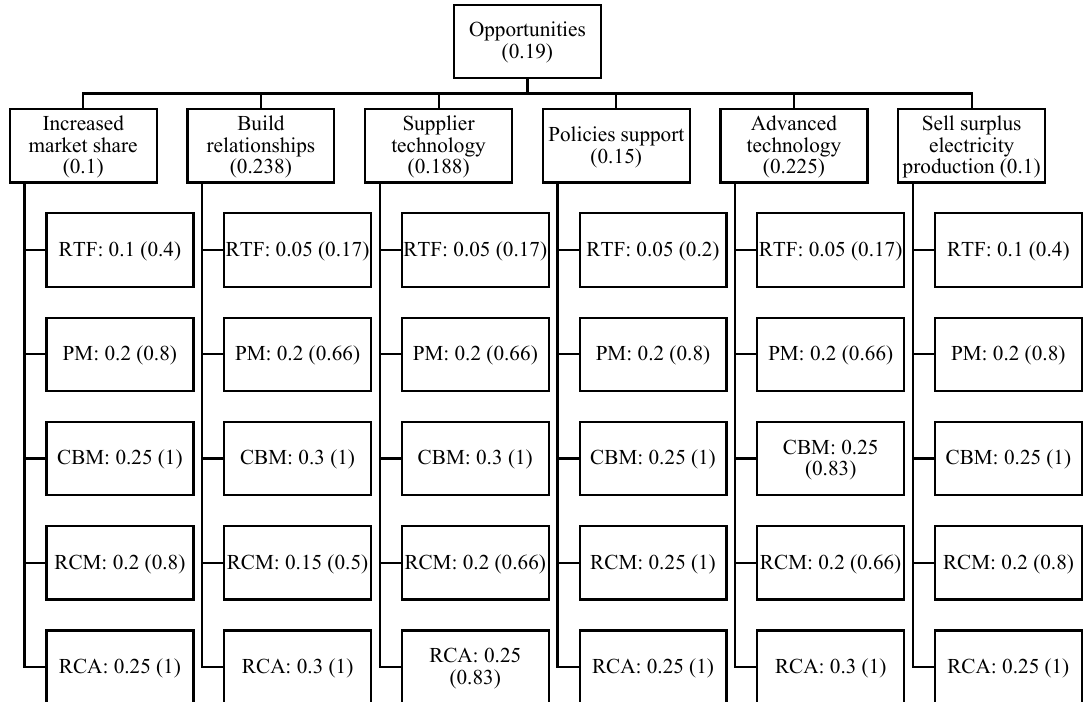
Fig. 4. Hierarchy chart of evaluated opportunities and alternatives